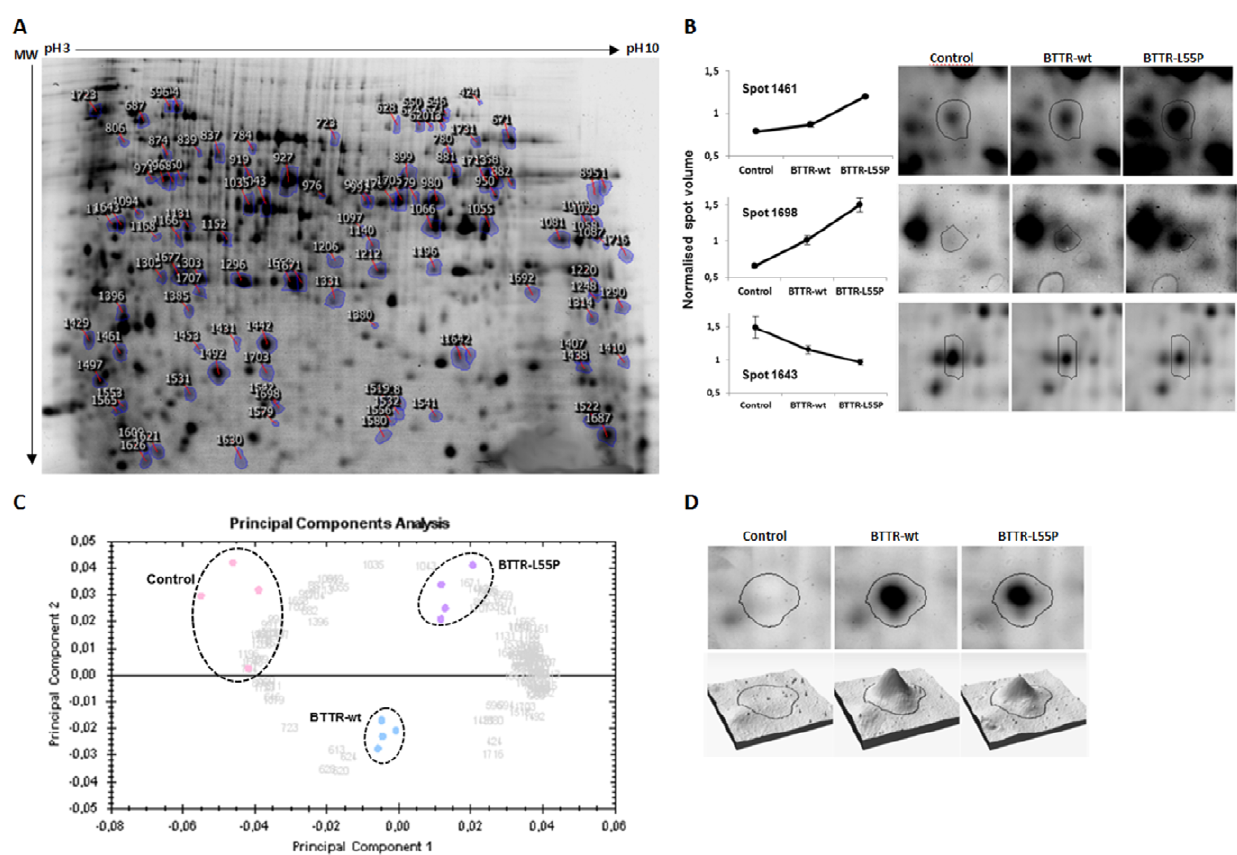
Figure 2. 2D-DIGE differential protein expression analysis. (A) Representative 2D-DIGE gel image showing the spot map corresponding to the internal standard (Cy2 labeling), which is common to all gels analyzed. Sample preparation and labeling were performed as described in the material and methods section. Indicated spots showed a statistically significant variation of spot volume with 95% confidence level (p , 0.05) and a minimal fold variation of 1.3. These spots were removed for subsequent protein identification by mass spectrometry (see Table 1 for code assignment). (B) Example of one protein present in higher abundance only in BTTR-L55P (Ubiquitin-like protein SMT3, spot 1461), one protein with an increase abundance in BTTR-wt and BTTR-L55P (FK506-binding protein, spot 1698) and one protein present in lower abundance both in BTTR-wt and BTTR- L55P (60 S acidic ribosomal protein P0, spot 1643). The spots of interested are encircled and the graphs represent the normalized spot volume. The spot volumes are an average of the 4 biological replicates used for each experimental group. (C) PCA of the 2D-DIGE results. Each data point in the PCA plot represents the global expression values for all spots with a significant ANOVA value (p , 0.05). The PCA clustered the 6 individual Cy3 and Cy5-labeled 2D-gel images into three discreet groups differentiated by two principle components PC1 and PC2, explaining a cumulative 82% of all the variation. A separation between the control (carrying the empty plasmid), cells expressing the non-amyloidogenic TTR-wt (BTTR-wt) and the amyloidogenic variant TTR-L55P (BTTR-L55P) is clearly observed. Replicate samples were encircled manually for illustration. (D) 2D-DIGE image analysis of the protein spot identified as human TTR. Figure shows the spot expression map and three-dimensional spot image for each experimental group.